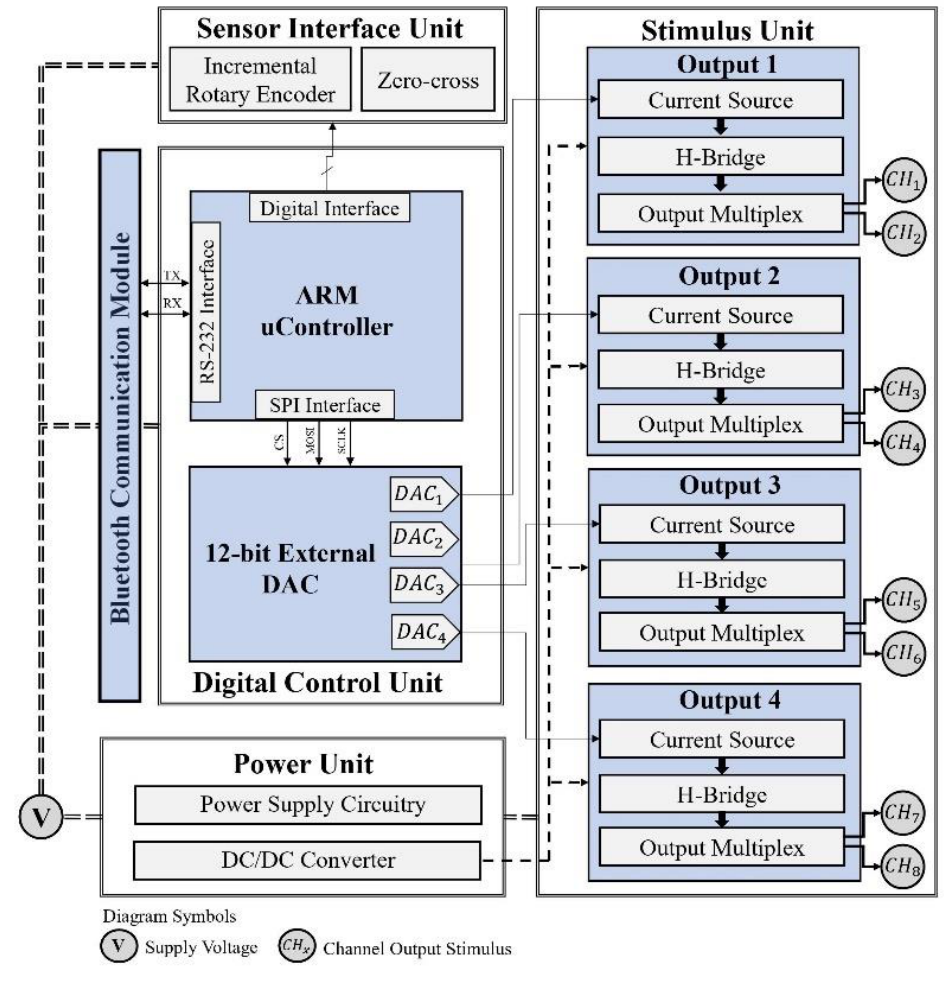
Figure 1. Proprietary 8 channel system architecture composed a digital control unit, responsible for the management of the electrical stimulation system and interface with sensors and communication units; a power supply unit; and a stimulation unit featuring a constant current source topology, which consists of a voltage–current converter, a Wilson current mirror, an H-bridge circuit, and multiplexing circuitry.